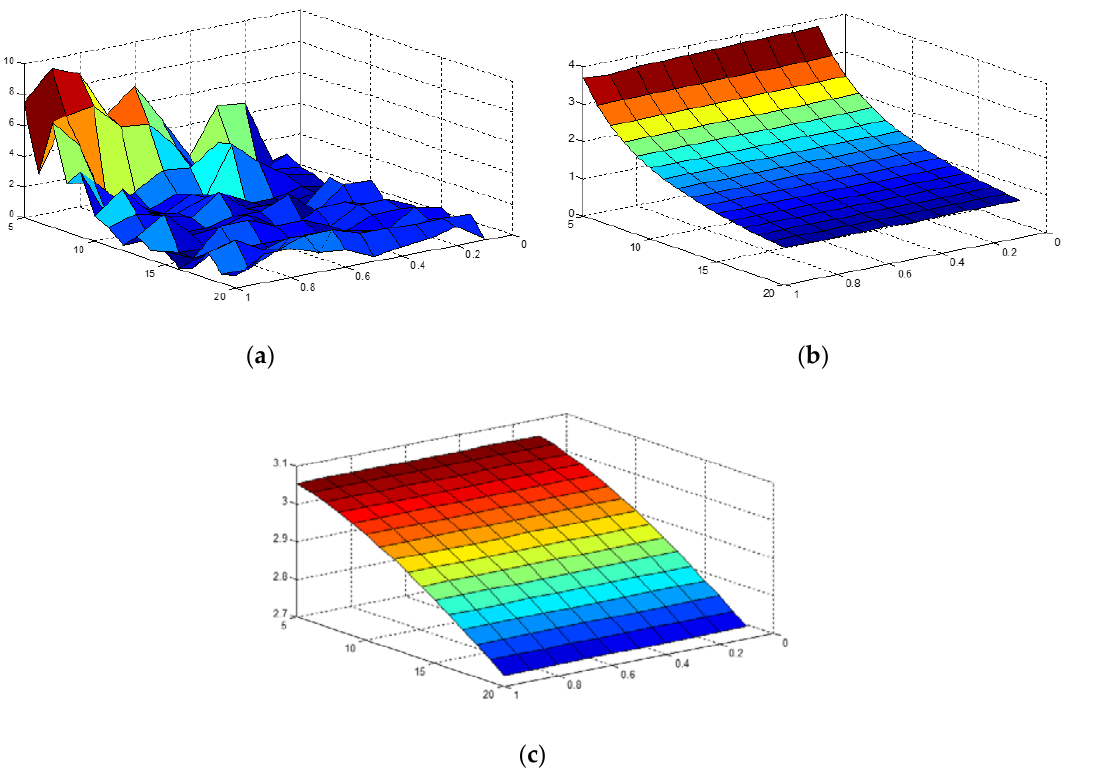
Figure 9. The e ff ect of large inductance on parallel systems: ( a ) Terminal voltage di ff erence; ( b ) change Figure 9. The effect of large inductance on parallel systems: ( a ) Terminal voltage difference; ( b ) change in circulating current; ( c ) change in in circulating current; ( c ) change in amplitude.